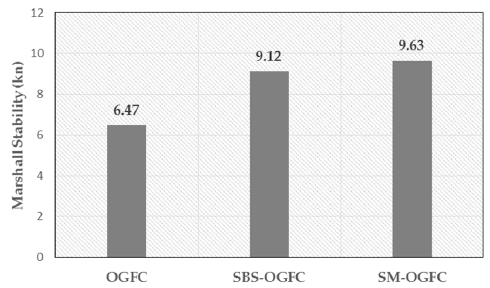
Figure 7. Marshall stability for all Open graded friction course (OGFC) mixtures.